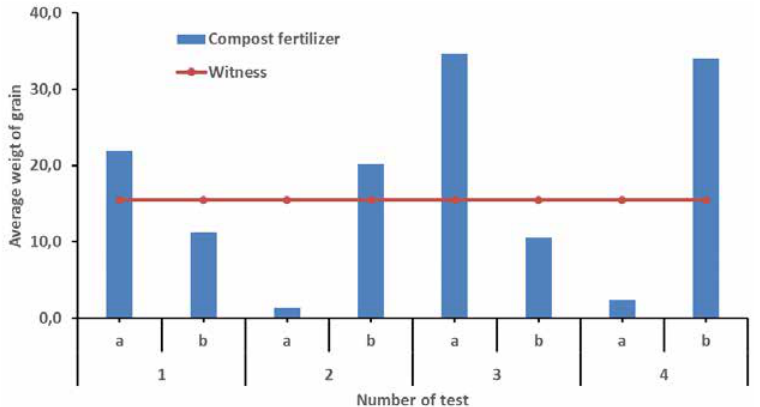
Fig. 7: Average weight of grain (g) of the ears harvested in each treatment, a = dose of 100 g, b = dose of 200 g